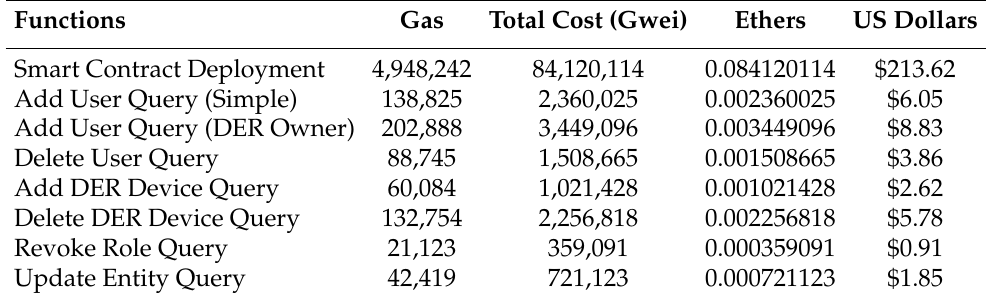
Table 3. Smart Contract-Related